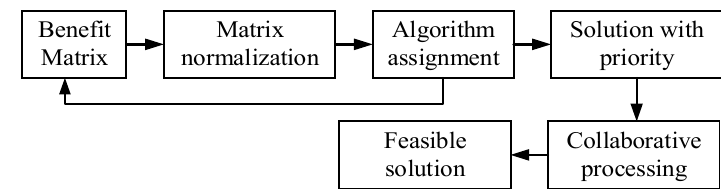
Figure 6. Process for improving the Hungarian algorithm.